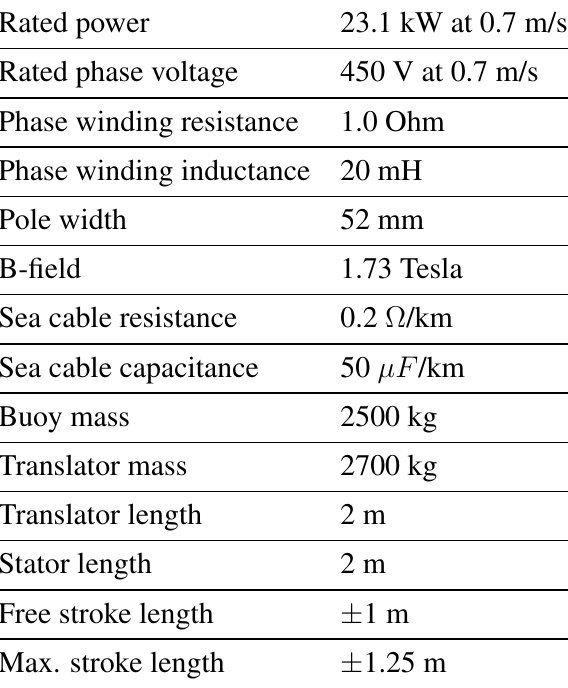
Table 1. Design Characteristics of Linear